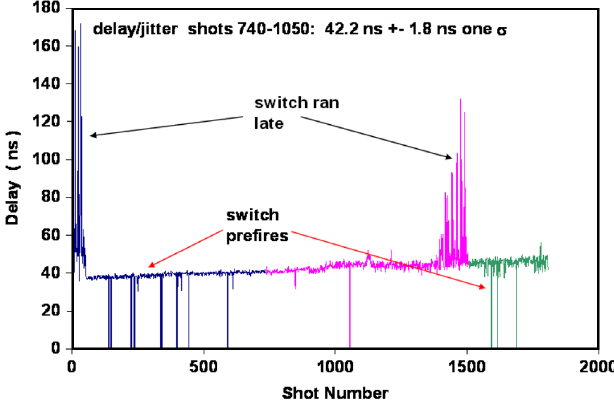
FIG. 16. (Color) Lifetime test results for the Sandia switch. This switch was operating at 72% of its self-breakdown voltage. The data was taken on three successive days as indicated by the color coding.